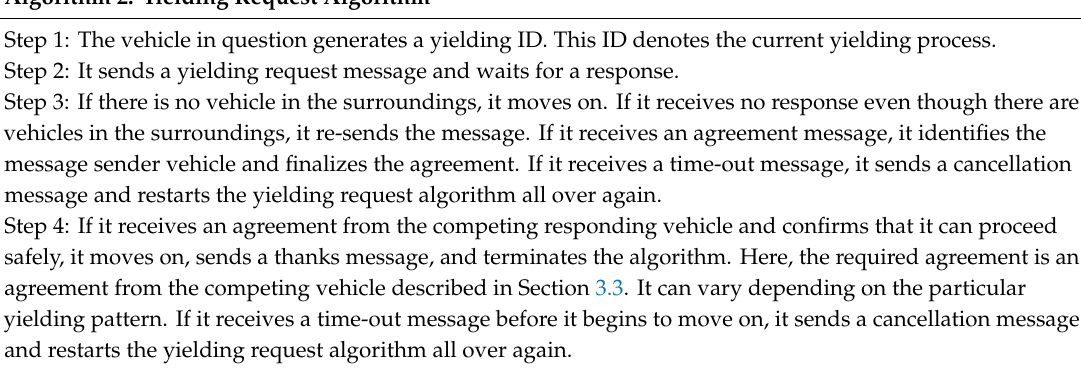
Algorithm 2. Yielding Request